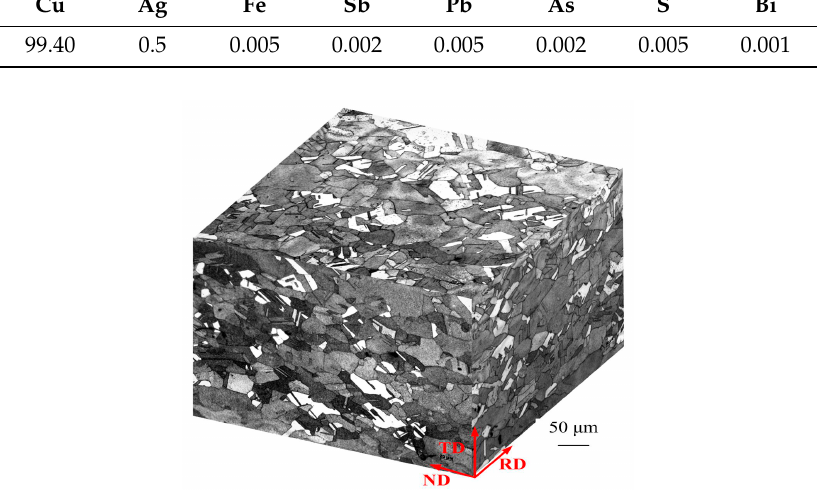
Figure 1. Microstructure of the as-received specimen along the rolling direction (RD), transverse direction (TD), and normal direction (ND).